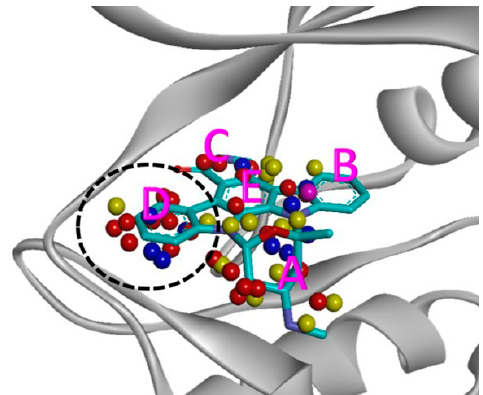
Figure 3. Superimposed TWNs around staurosporine in the IRAK4 binding pocket. We divided the ATP binding site into five regions (A–E) based on staurosporine’s binding mode, to analyze TWN patterns. Three-, four-, five-, and six-membered water rings are represented by red, yellow, blue, and purple spheres, respectively. The D site with a unique water network pattern is highlighted using a black dashed circle.